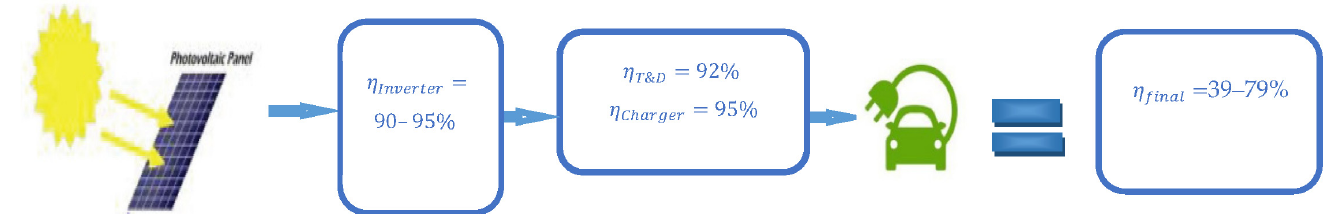
Figure 5. The final efficiency of EVs’ charging considering the electricity coming from PV.